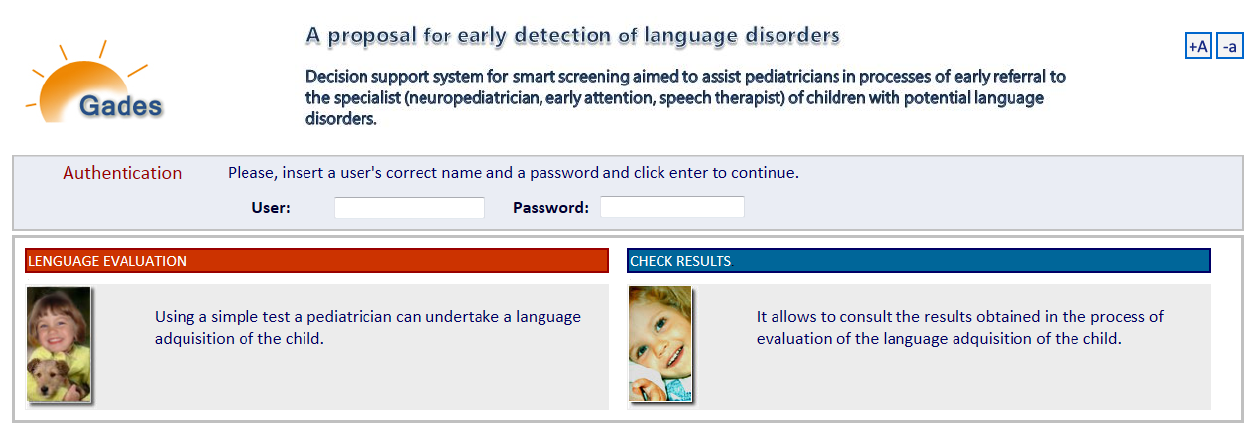
Figure 10. Access to the early detection tool of language disorders.